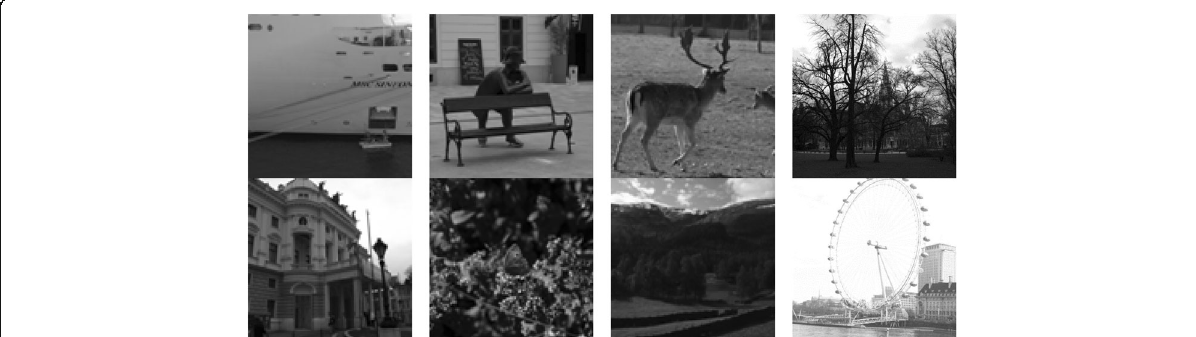
Fig. 8 Sample image of BOWS-2 image databases [26]. Sample image of BOWS-2 image databases. To verify the suitability of the hiding scheme for various image types, 9,074,512× 512 grayscale images were selected from the BOWS-2 image databases as raw